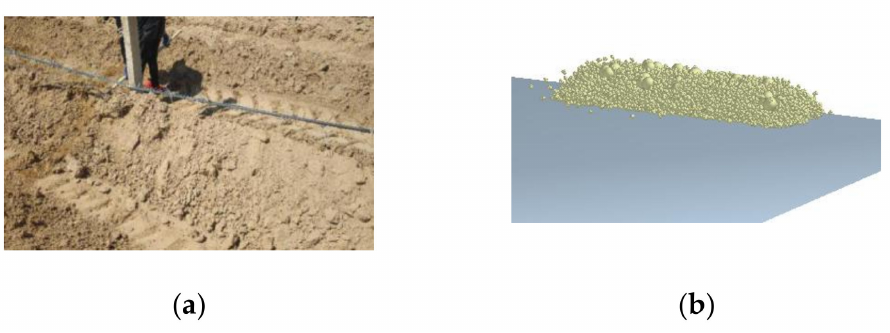
Figure 9. ( a ) Field model. ( b ) Simulation model.